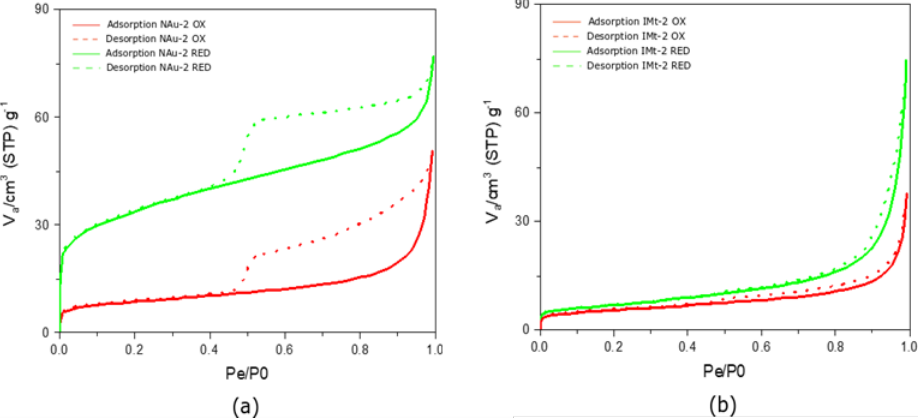
Figure 2. Nitrogen Adsorption isotherms for the NAu-2 and IMt-2 oxidized and reduced samples.